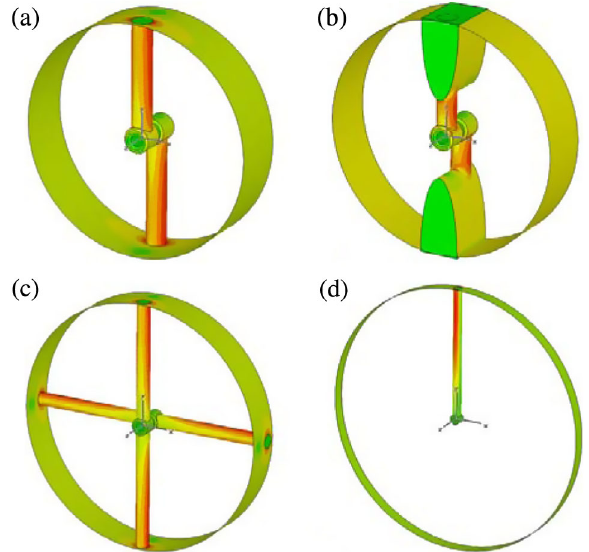
FIG. 1. Surface-current distributions for the structures in Table II: (a) IH; (b) IH with vanes; (c) CH; and (d) DTL. Red means high current density, green—low. The spatial and current scales are different in all pictures, cf. Table II.